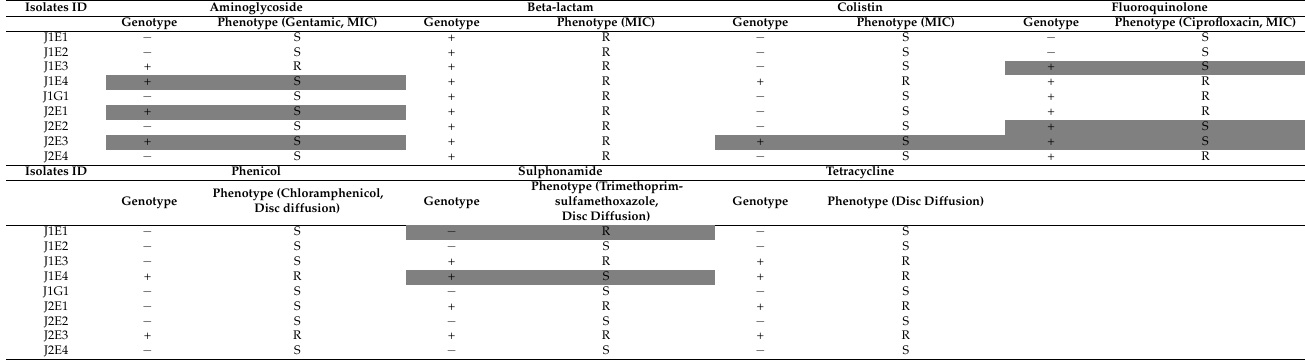
Table 3. The comparison of phenotypic and genotypic